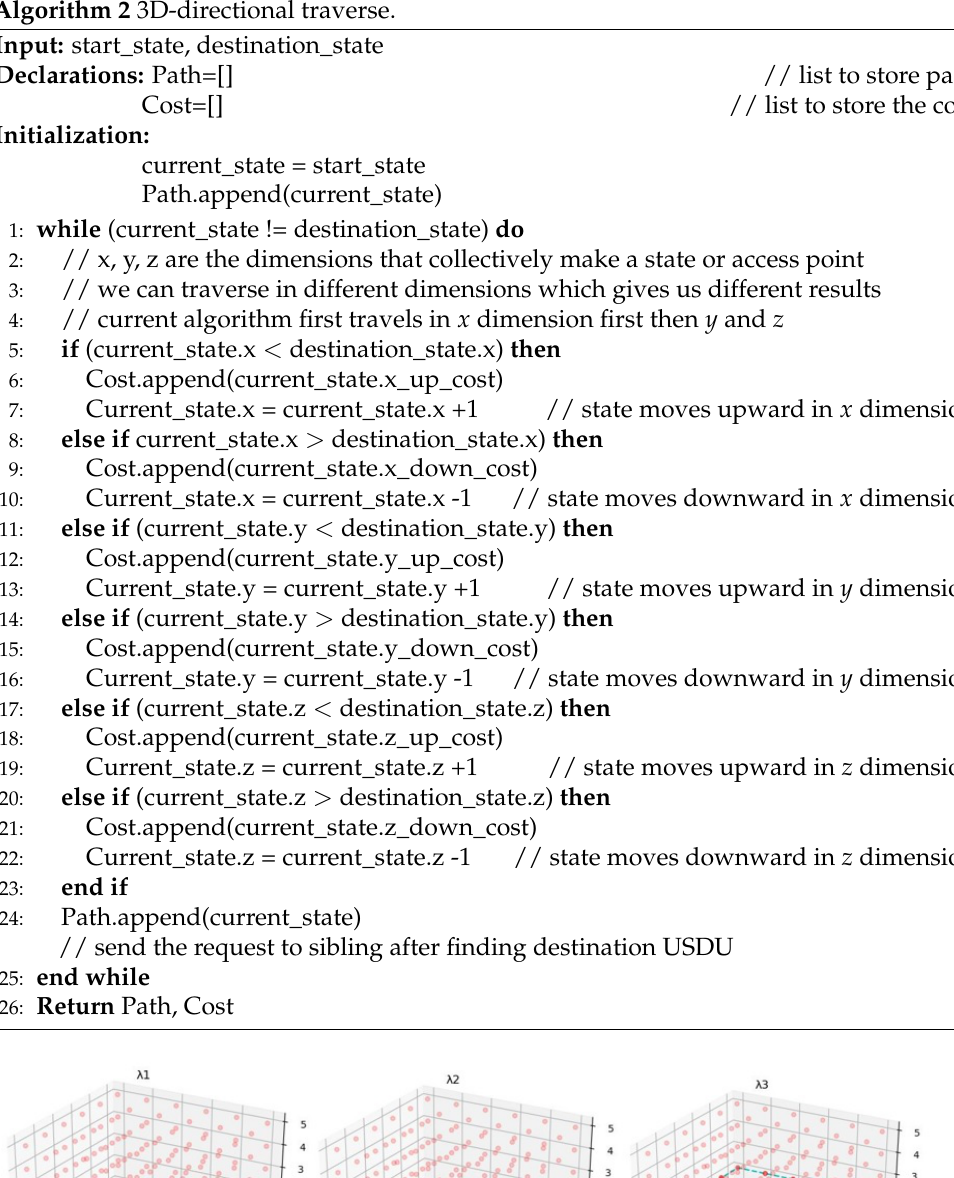
Algorithm 2 3D-directional traverse.